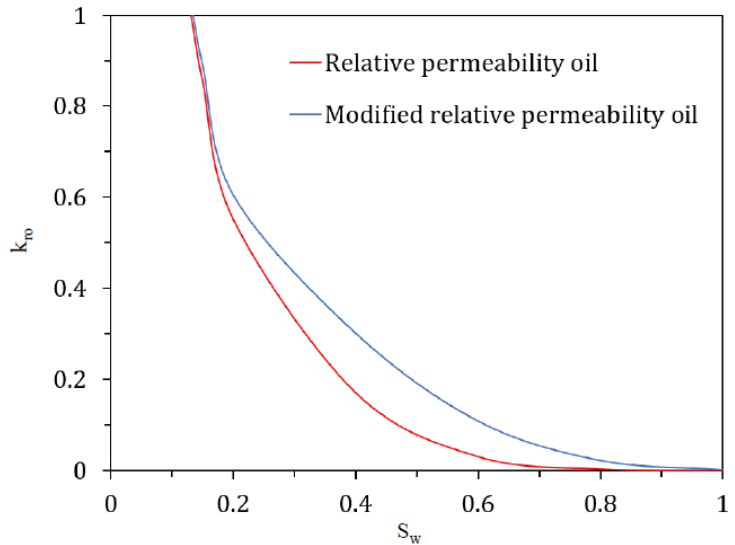
Figure 23. Original and modified oil relative permeabilities, with a polymer concentration of 10 mol/m 3 .